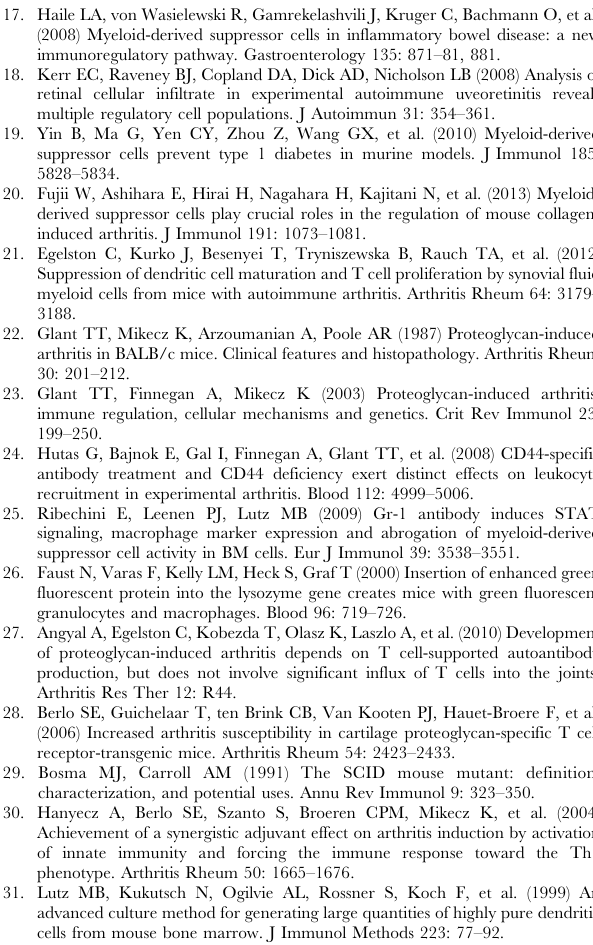
Figure S2 Screening of BM-MDSCs and SF cells for the presence of osteoclast precursor-like cells. Flow cytometry analysis was performed on the same ( A ) BM-MDSC and ( B ) SF samples described in Figure S1, but with gating on CD11b lo/ 2 cells (red arrows) containing putative Ly6C hi CD115 + osteoclast precursors. CD115 + osteoclast precursor-like cells were not detected in either the Ly6C hi/int or Ly6C lo/ 2 fraction of ( A ) CD11b lo/ 2 BM-MDSCs ( B ) or CD11b lo/ 2 SF cells. The representative samples show flow dot plots of cells from 1 of 5 independent BM-MDSC cultures, and from 1 of 3 separate pools of SF cells. Figure S3 Effects of BM-MDSCs of the expression levels of dendritic cell (DC) maturation markers MHC II and CD86. DCs and BM-MDSCs were generated from BM as described in the Methods. DCs were cultured for 3 days with or without BM-MDSCs. The densities of major histocompatibility complex class II (MHC II) and CD86 maturation markers on the surface of DCs (CD11c + cells) were determined by flow cytometry and the results expressed as mean fluorescence intensity (MFI). ( A )